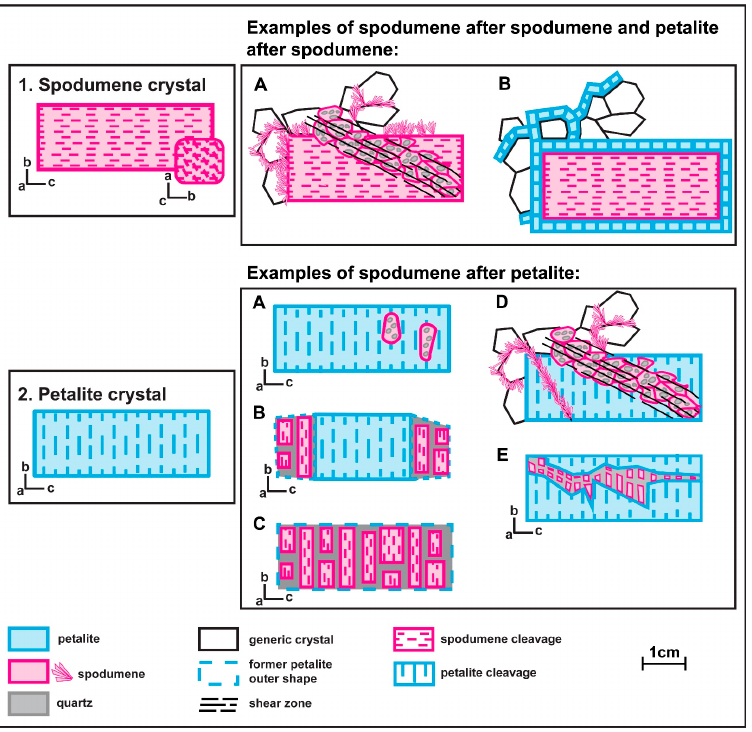
Figure 2. Examples of the distinct spodumene and petalite textures found in the aplite-pegmatites of the Barroso–Alvão pegmatite fi